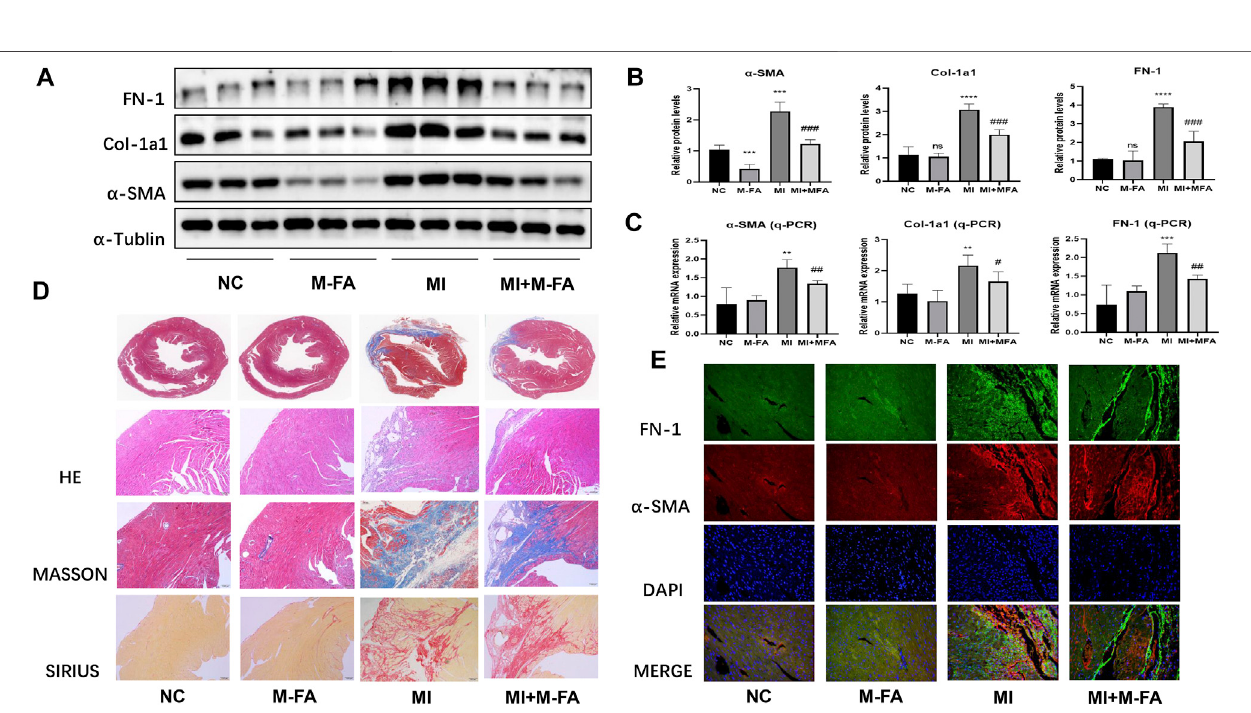
FIGURE 3 | MFA reduced fi brosis level in MI mice. (A – C) Protein (A. B) and mRNA (C) expression levels of fi brosis-related genes in different mice groups ( n (cid:2) 6). (D – E) Tissue staining (D), and immuno fl uorescence (E) were performed to compare the fi brosis area and fi brosis-related genes expression. (*compared with negative control: ** p < 0.01, *** p < 0.005, **** p < 0.001. # Compared with the MI group: # p < 0.05, ## p < 0.01, ### p < 0.005).